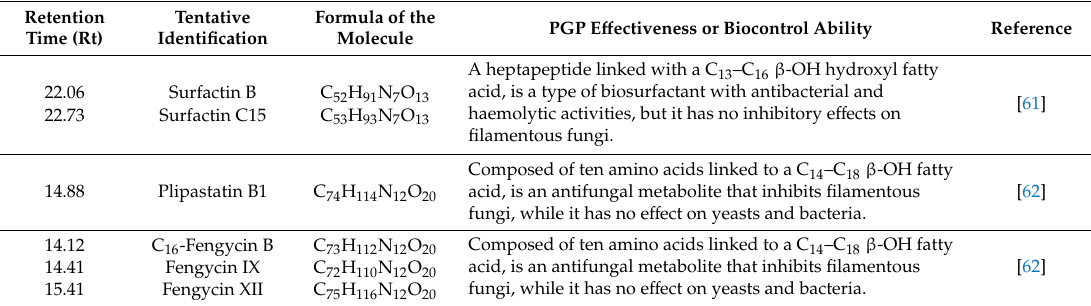
Table 2. Results retrieved from the LC-MS analysis of the B. velezensis strain OEE1. 523